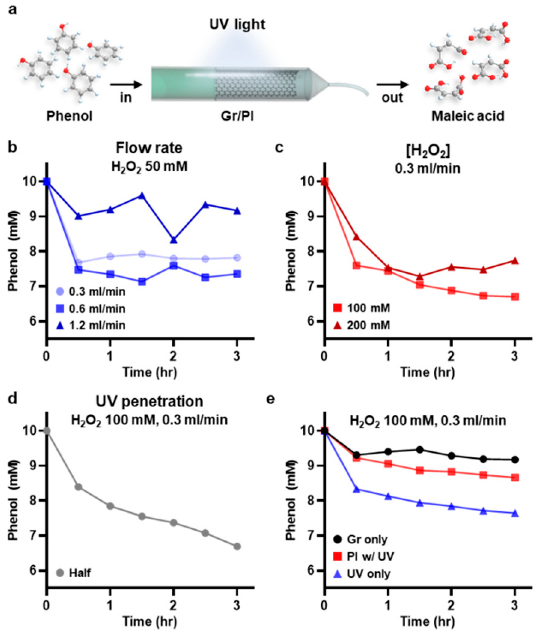
Figure 3. Optimizations of continuous phenol degradation by the graphene column. ( a ) Schematic drawing of the graphene column. The optimal condition of graphene column was found by comparing the e ff ect of ( b ) flow rate of solution (10 mM phenol and 50 mM H 2 O 2 ), ( c ) concentration of H 2 O 2 at a fixed flow rate of 0.3 mL / min, and ( d ) the extent of graphene’s column coverage. ( e ) The synergistic e ff ect of graphene and UV light treatment is considerable compared to either graphene or UV light treatment.